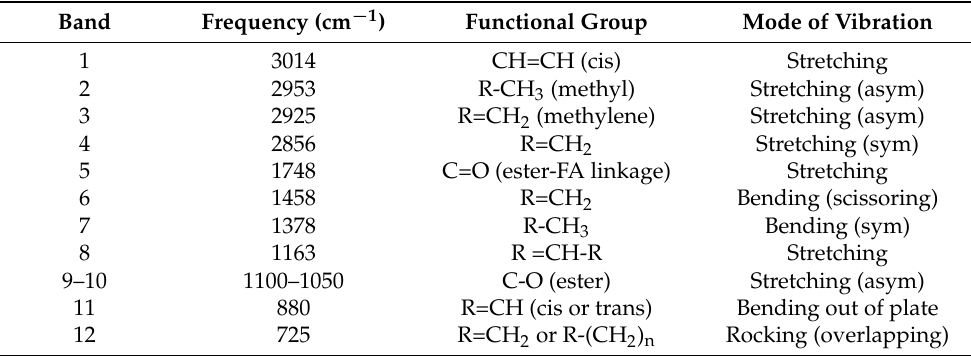
Figure 2. FTIR spectra of agri-food by-products in the mid-infrared region (4000–400 cm − 1 ). The identification of numbers was in Table 3. Table 3. Assignment of the infrared (IR)